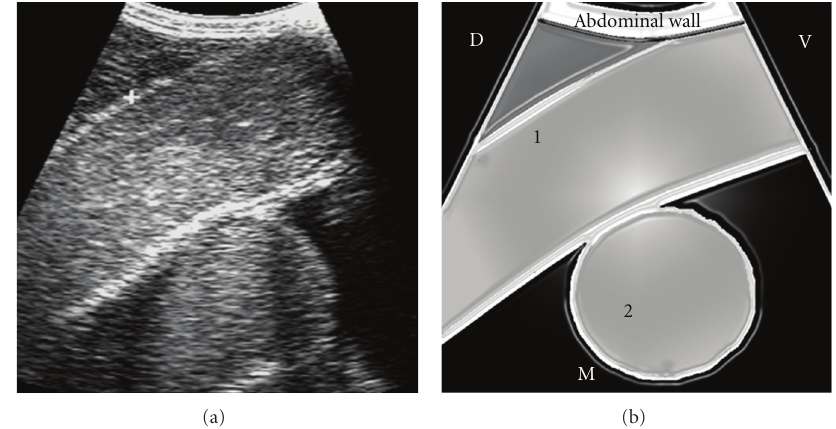
Figure 5: Ultrasonogram of dilated jejunal loops in jejunal intussusception imaged from ventral third of flank in longitudinal and cross- sections. 1- Pre-intussusception dilated loop in longitudinal section with echogenic content, 2- Pre-intussusception dilated loop in cross- section with echogenic content, D: Dorsal, V: Ventral, M: Medial.